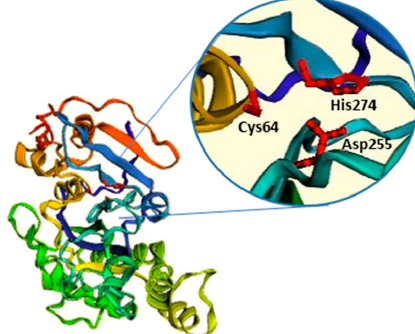
Figure 3. Microbial TG structure. mTG is composed by a single, compact domain. The amino acids